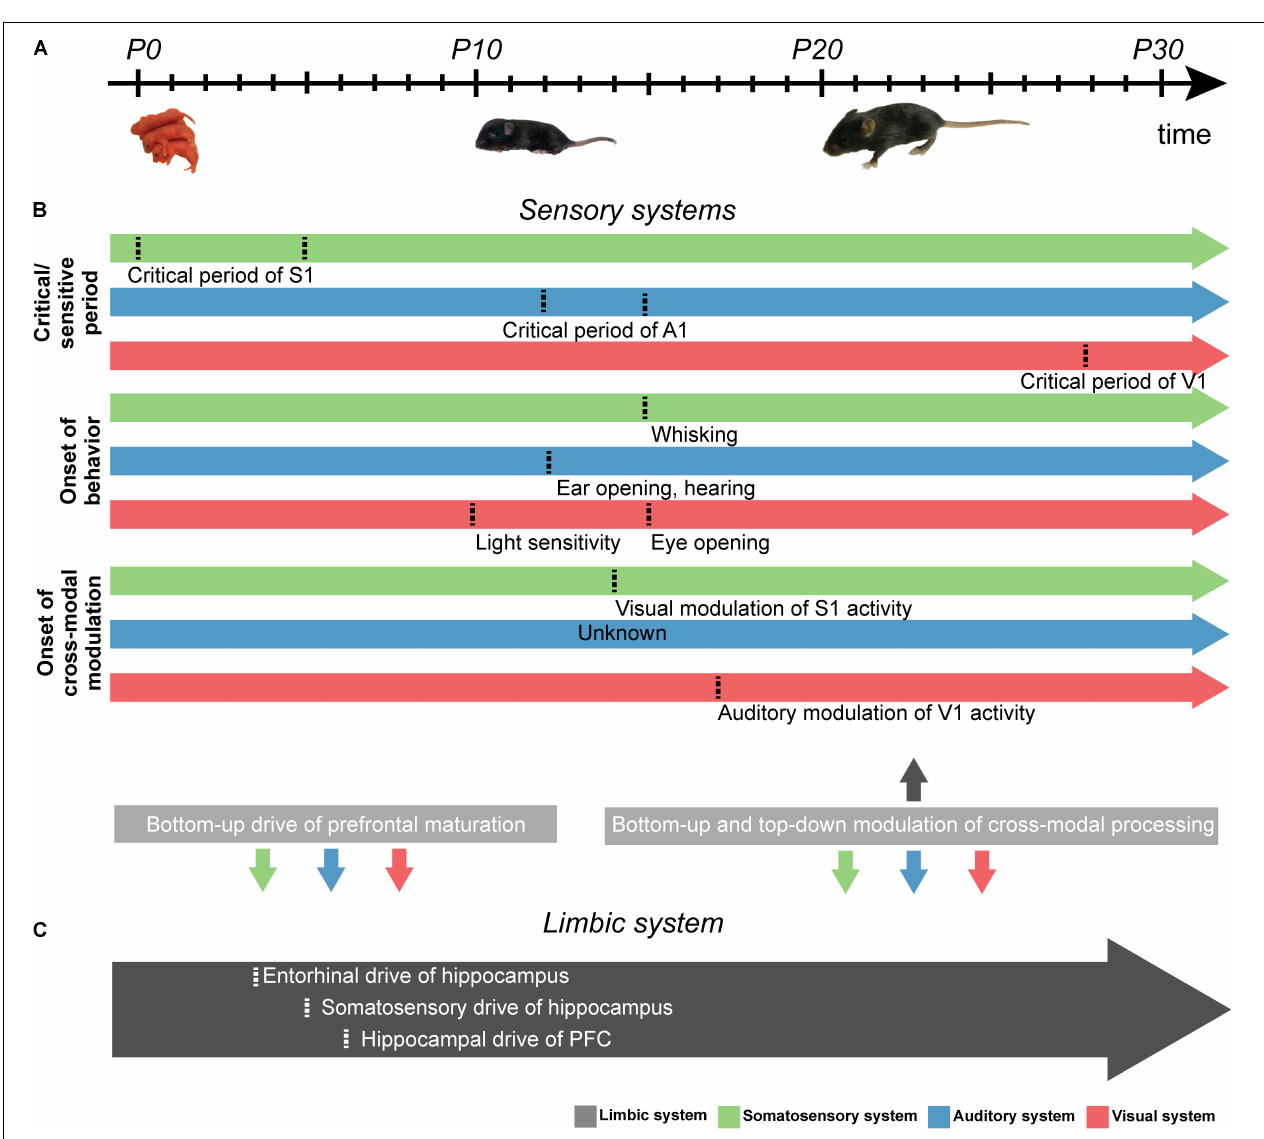
FIGURE 2 | Schematic diagram displaying the developmental milestones of sensory and limbic development in rodents. (A) Schematic illustration displaying the developmental timeline of sensory development from postnatal day (P) zero onward. (B) Schematic arrows showing the time points (marked by dotted line) of (i) the critical/sensitive period of somatosensory (green), auditory (blue), and visual (red) development, (ii) the onset of unisensory behavior, and (iii) the start of cross-modal modulation. Uni- and cross-modal inputs in the first days of life are hypothesized to drive the development of the limbic system in a bottom-up manner, while bottom-up as well as top-down interactions between the primary sensory cortices and limbic system are present at later stages of development (gray boxes, bottom). (C) Same as (B) for PFC. Time points shown in gray arrow mark developmental milestones of limbic system